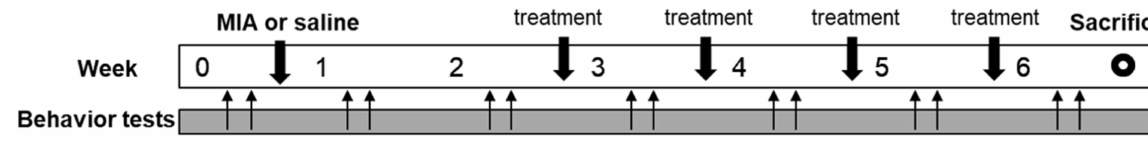
Figure 5. Timeline of local injection of the NGF antibody in an MIA-induced OA rat model.